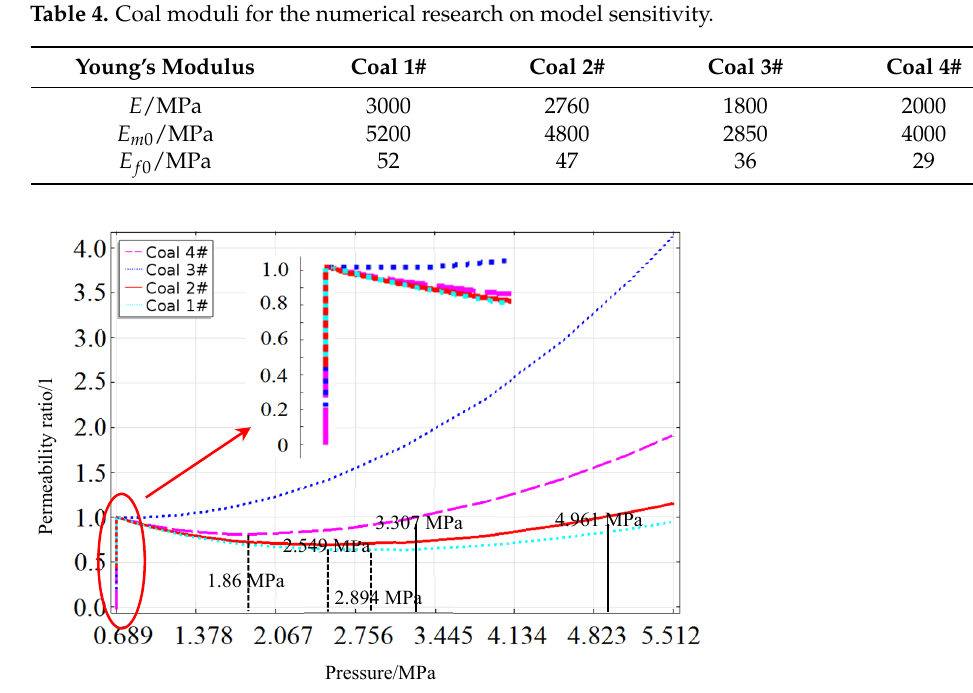
Table 4. Coal moduli for the numerical research on model sensitivity.